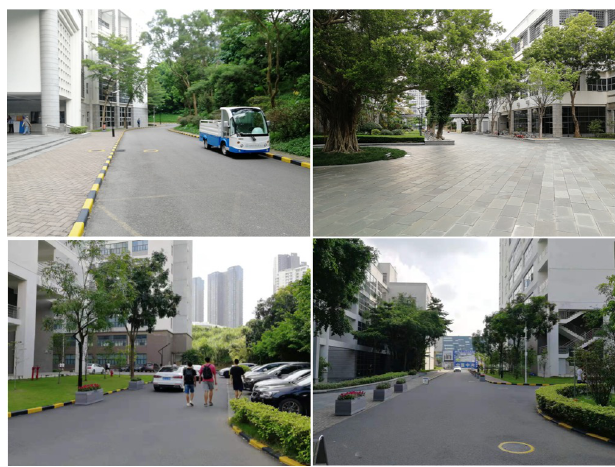
Figure 9. Photos of our campus environment.